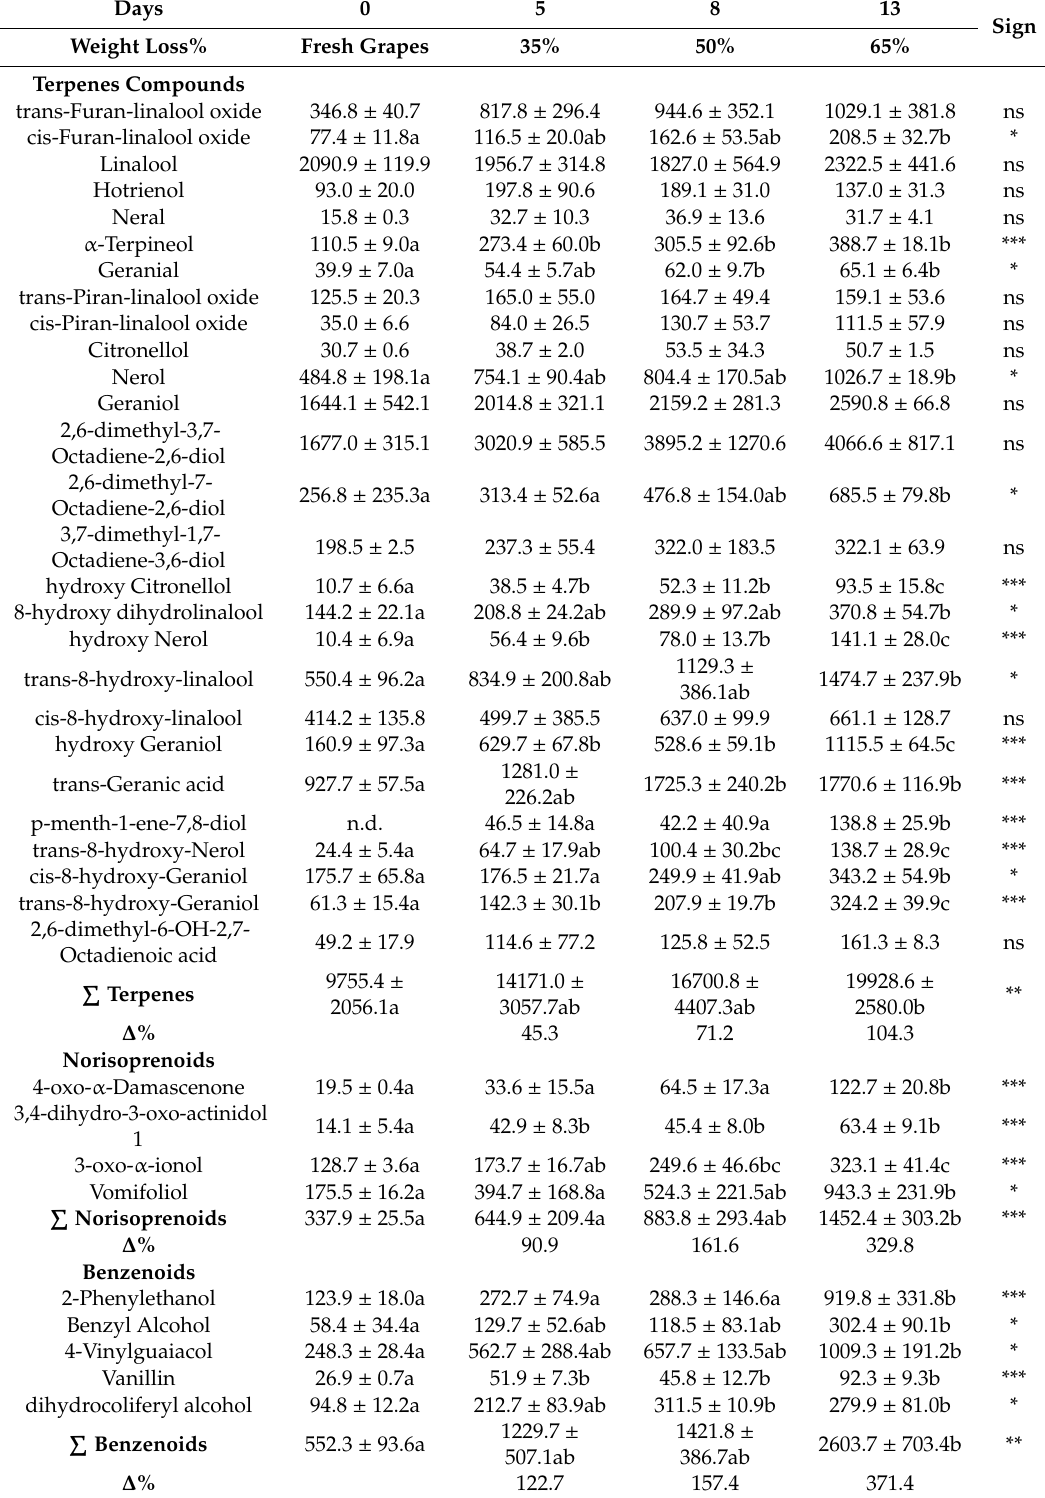
Table 5. Evolution of glycosylated volatile compounds of Muscat Alexandria grapes during dehydration ( µ g / kg